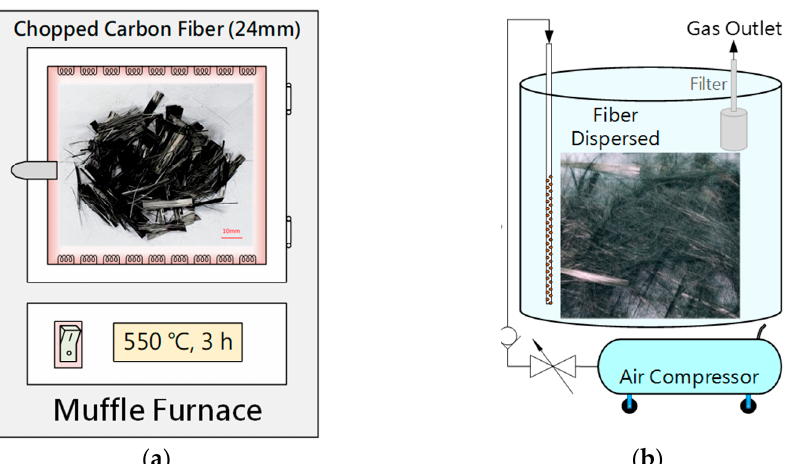
Figure 2. Carbon fiber sizing removal process. ( a ) Heat ‐ treatment method; ( b ) pneumatic disper ‐ sion.